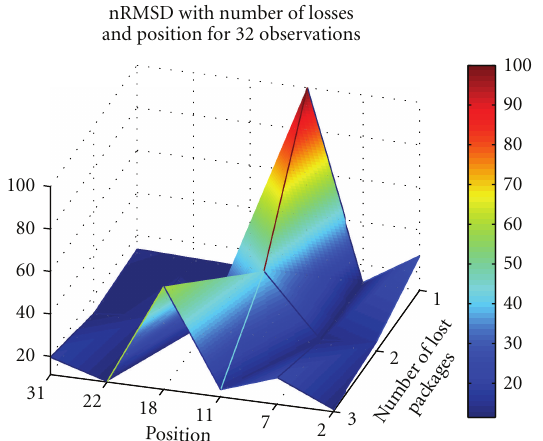
Figure 4: Dependence on number and position of lost packets, for Daubechies 4, M = 32, and τ coe ff = 0 . 24, of the nRMSD of a reconstructed ECG waveform.